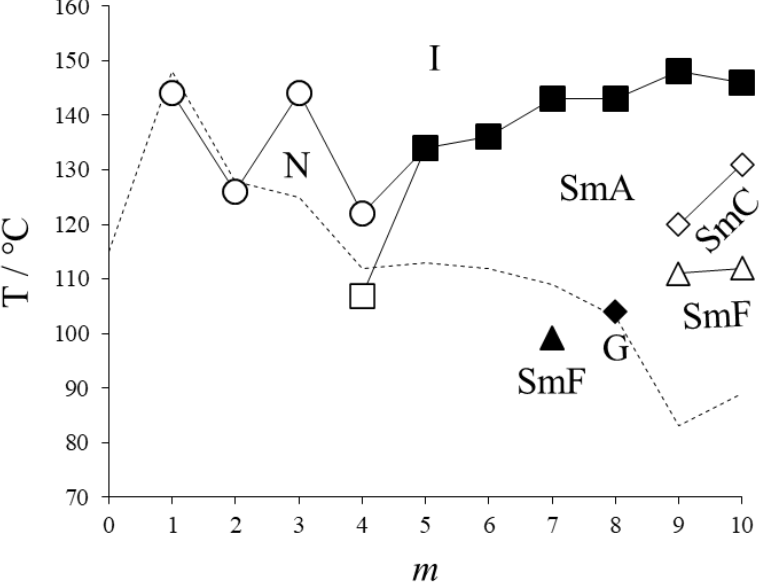
Figure 3. The dependence of the transition temperatures on the number of carbon atoms, m , in the terminal chains for the m .O5O. m series [10]. The broken line joins the melting points. Filled squares denote T SmAI ; unfilled squares T SmAN ; circles T NI ; unfilled diamonds T SmASmC ; filled diamonds T SmAG ; filled triangles T SmASmF ; unfilled triangles T SmCSmF .